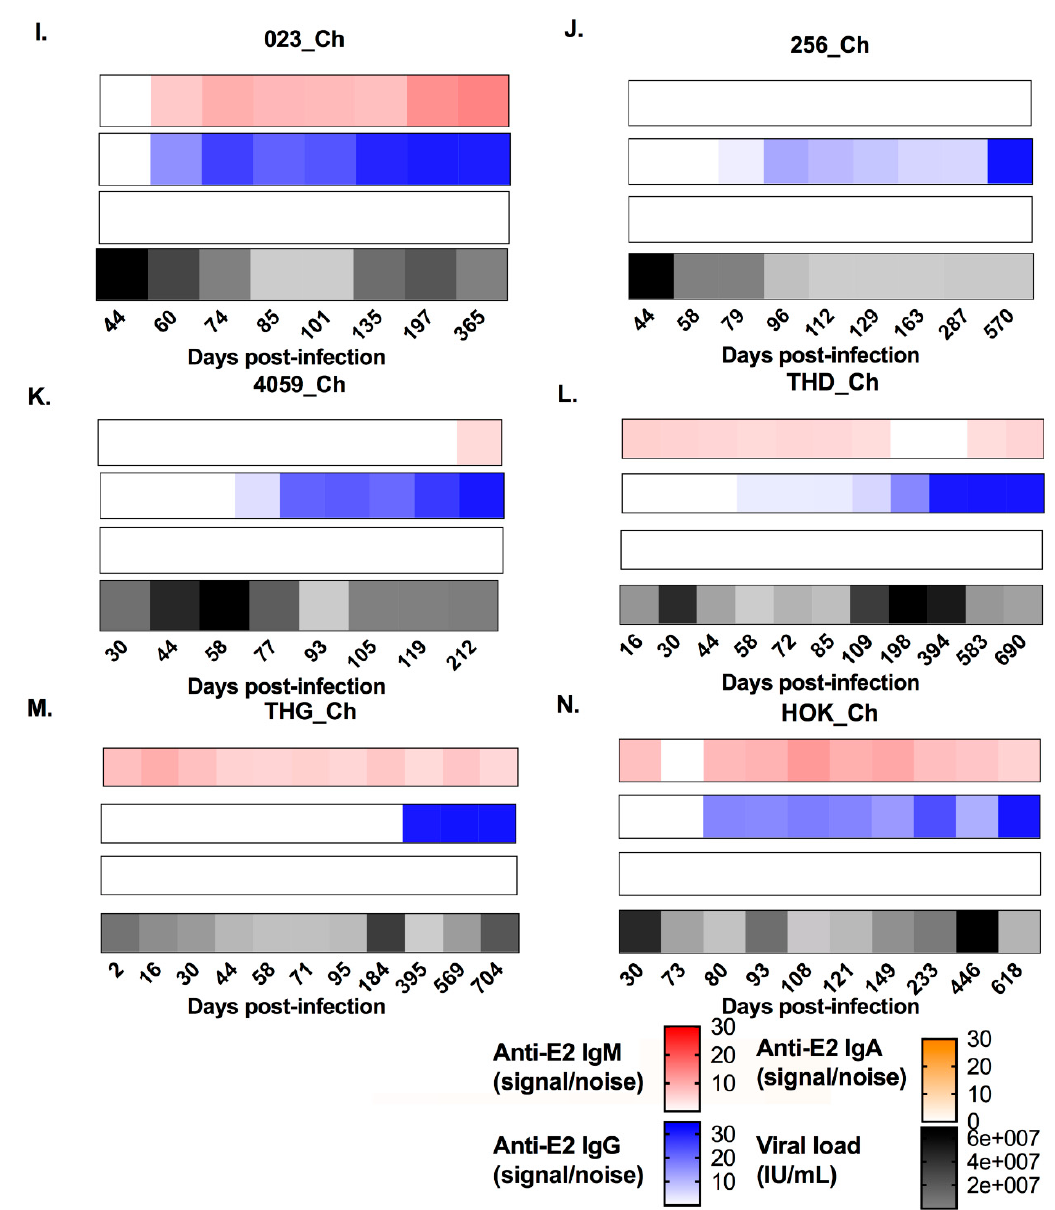
Figure 1. Heat maps representing the longitudinal patterns of anti-hepatitis C virus (HCV) envelope protein 2 (E2)-antibody isotype utilisation (signal / noise) for anti-E2 immunoglobulin M (IgM), IgG, and IgA responses, as well as HCV RNA levels (IU / mL). Panels A – G show subjects who cleared the infection. Panels H – N show subjects who developed chronic hepatitis. IgM is represented in red, IgG is represented in blue, IgA is represented in orange, and longitudinal HCV RNA levels (IU / mL) are represented in black (see key). Days post infection (DPI) are indicated below each heat map. All results were generated in duplicate from longitudinal serum samples collected for each subject.